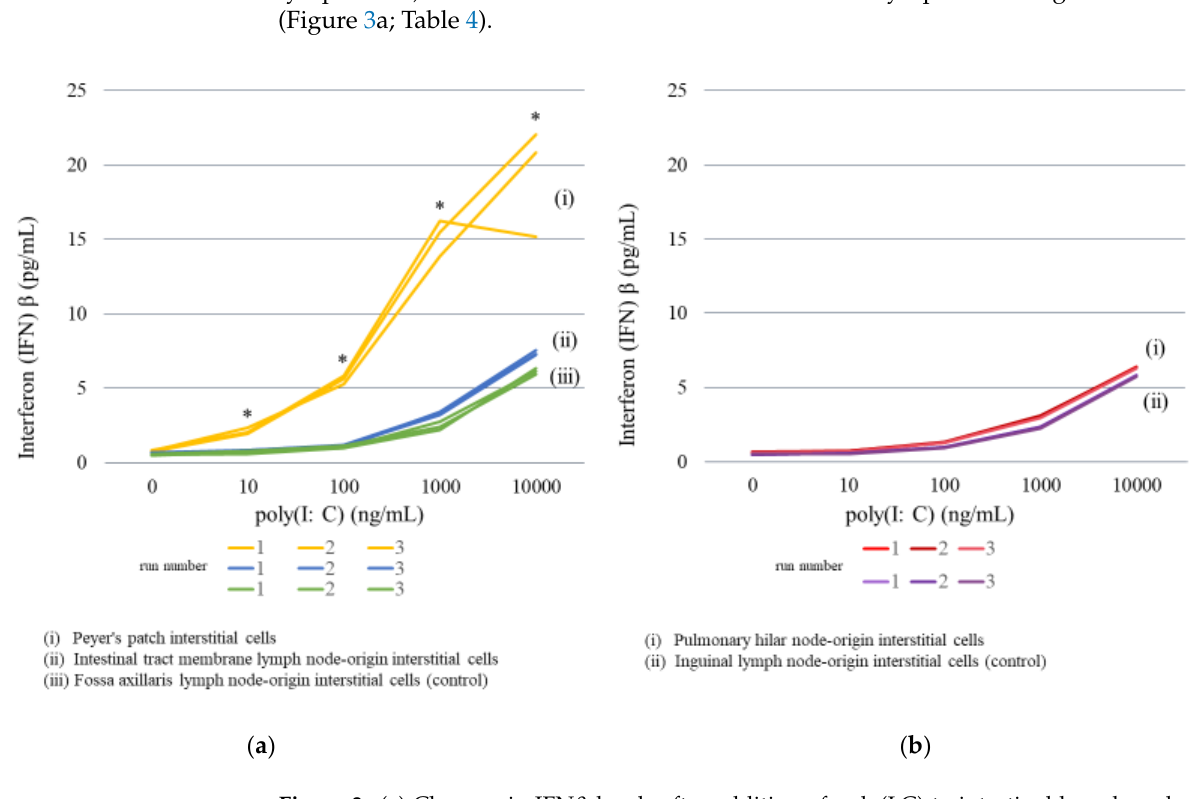
Figure 3. ( a ) Changes in IFNβ levels after addition of poly(I:C) to intestinal lymph node-related cultured cells: ( i ) Peyer’s patch interstitial cells, ( ii ) intestinal tract membrane lymph node-origin interstitial cells, ( iii ) fossa axillaris lymph node-origin interstitial cells (control). ( b ) Changes in IFNβ levels after addition of poly(I:C) to respiratory lymph node-related cultured cells by concentration: ( i ) Pulmonary hilar node-origin interstitial cells, ( ii ) inguinal lymph node-origin interstitial cells (control). * Indicates a significant difference between the groups, at p < 0.05 by the Games–Howell test. Pulmonary hilar node-origin interstitial cells treated with 100 ng/mL poly (I:C) ex- hibited IFN β expression levels of 1.27–1.33 pg/mL (average = 1.29 pg/mL). This